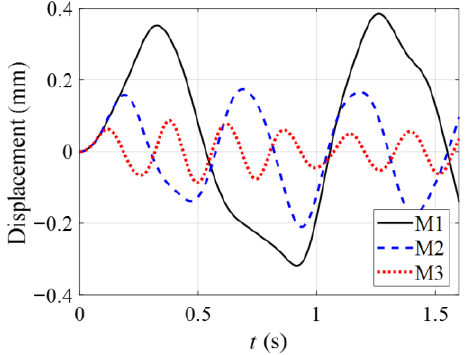
Figure 8. Time histories of point A of M1~M3, ω 0 = π /100 (rad/s), T = 0.1.